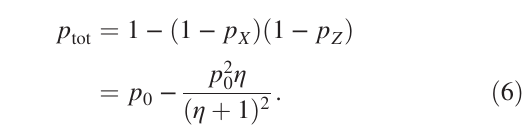
strengths of Z -type and X -type errors. The total probability of any error is